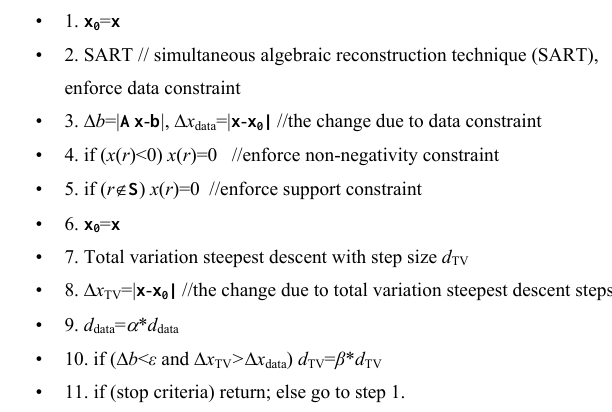
Fig. 7. The pseudo-code of the constrained retrieval algorithm. The constraints implemented in the retrieval algorithm include smoothness, non-negativity, and support constraints. x and b represent the atmospheric absorption coefficients and the observed brightness temperatures. d data and d TV are the step sizes for the data constraint and for the total variation steepest descent, respectively. α and β are the dampening factors, 0 < β < α < 1.